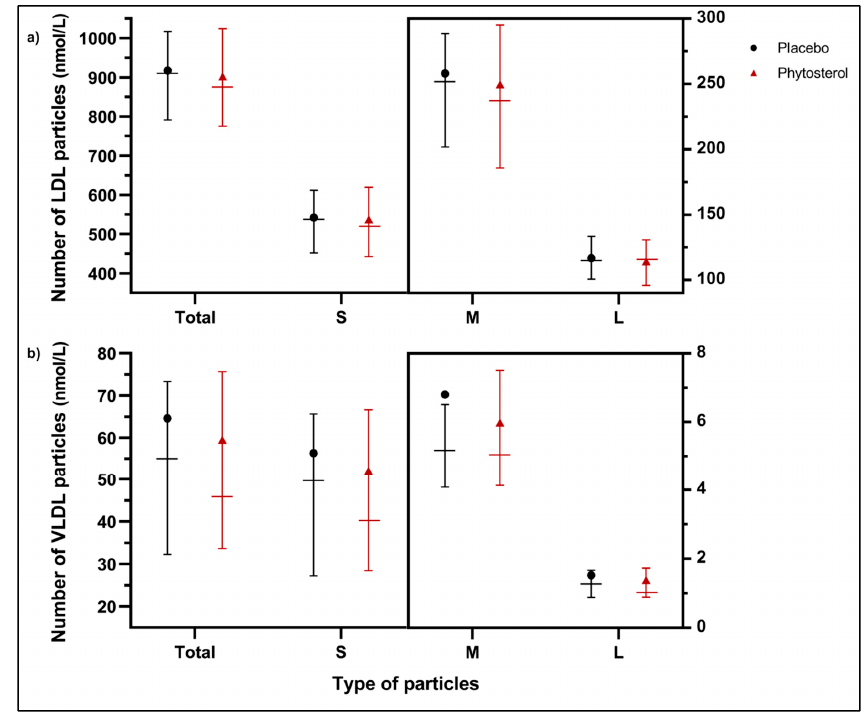
Figure 5. Number of LDL-p ( a ) and VLDL-p ( b ) by subclass (small, medium and large) at V4 by the group. Black lines represent the placebo group, and red lines the phytosterol group. Horizontal lines represent the interquartile range and the median. Black points (•) represent the mean for the placebo group, and red triangles ( ▲ ) represent the mean for the phytosterol group. M and L particles are measured with the right y-axis.